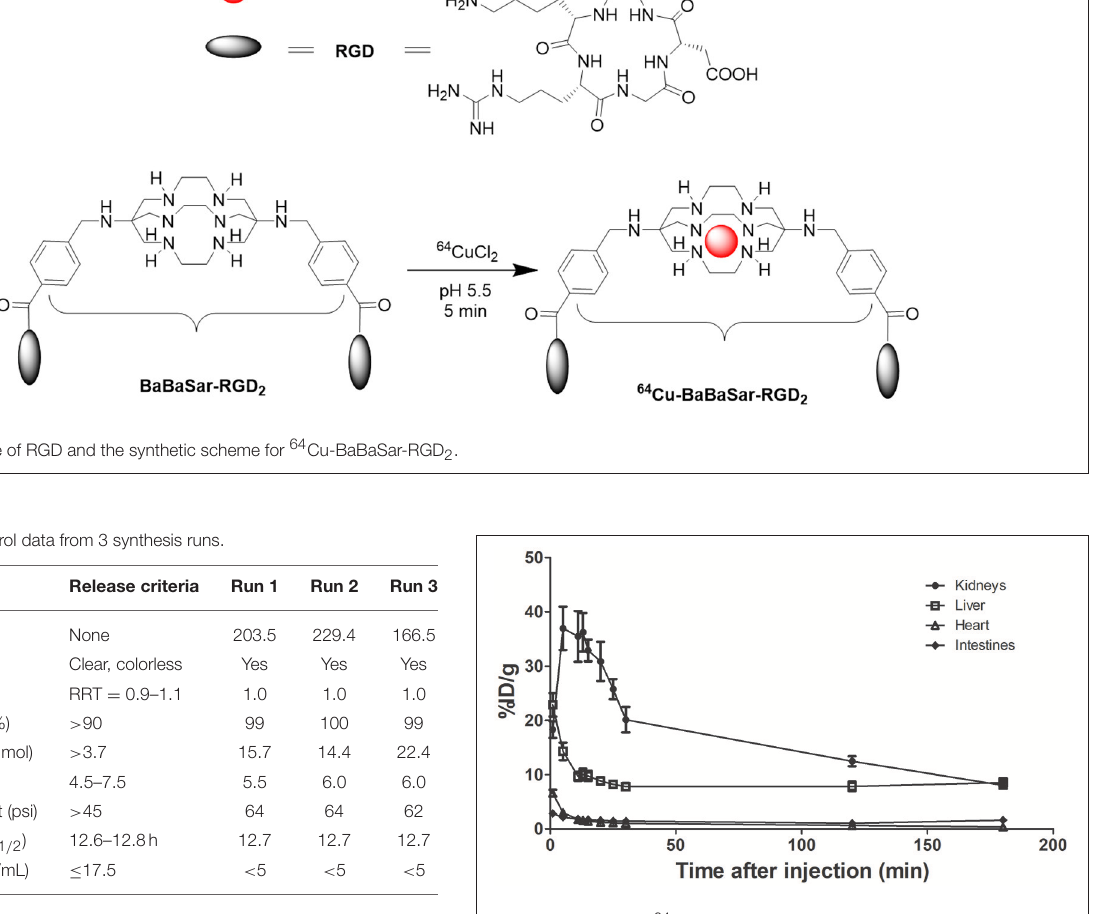
FIGURE 2 | TACs for 64 Cu-BaBaSar-RGD 2 in kidneys, liver, heart, and intestines. There was no voiding because monkey was